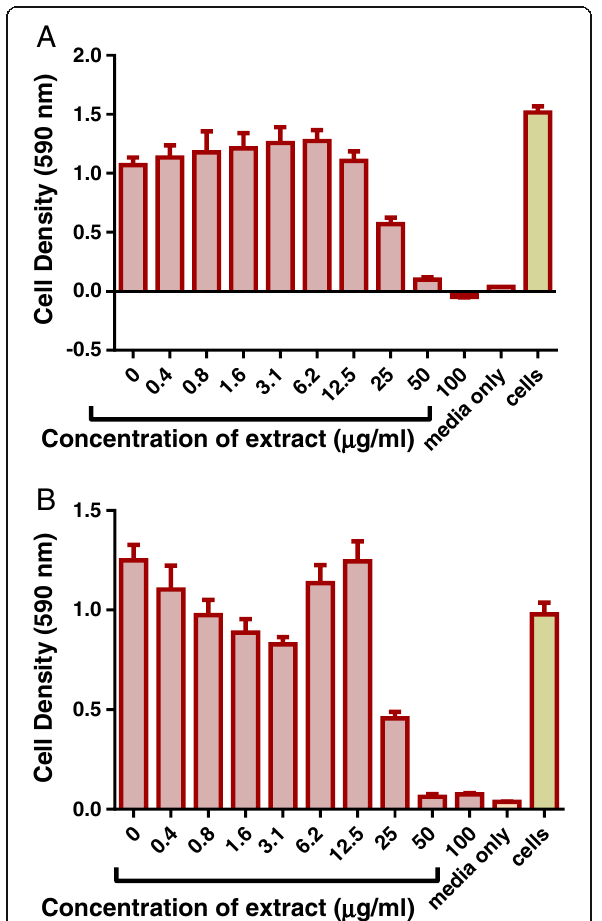
Fig. 3 The eeffects of P. curatellifolia ethyl acetate fraction and the methanol extract on M. smegmatis growth. The M. smegmatis mc 2 155 laboratory strain at a concentration of 2 × 10 6 cfu/mL was treated with different concentrations of the ethyl acetate ( a ) and methanol ( b ) extracts. The bacteria were incubated with extracts at 37 ̊ C for 20 h and cell density was determined by measuring absorbance of reduced MTT at 590 nm. The error bars on the graphs indicates the standard deviation from the mean ( n = 4). Dunnet ’ s multiple comparison test was used to compare columns using Graph pad prism 6 software. The asterisks (*) indicate statistical significant differences with the sterility control (media) * < 0.05 *** < 0.0001